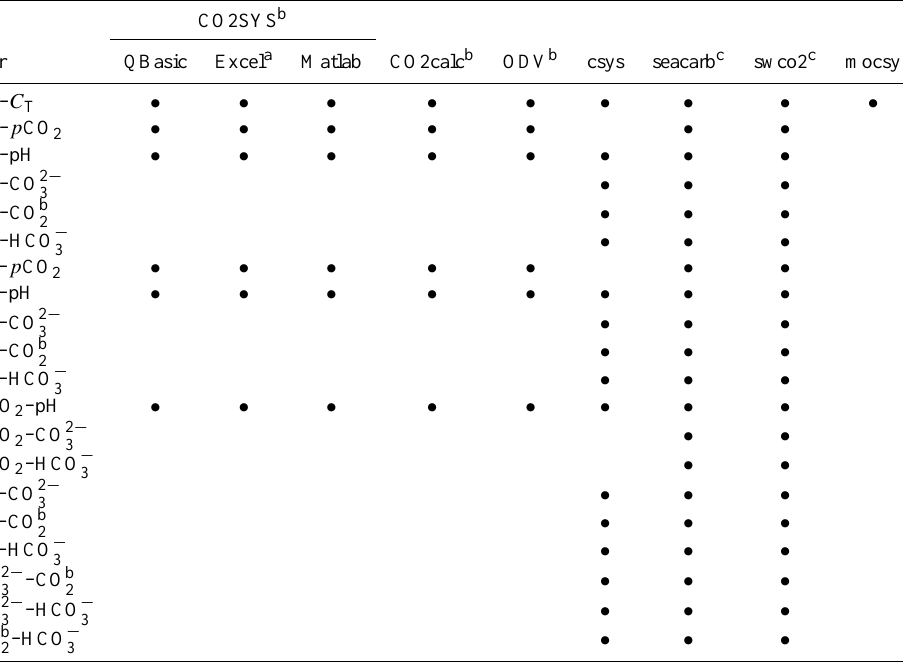
Table 4. Available input pairs for each